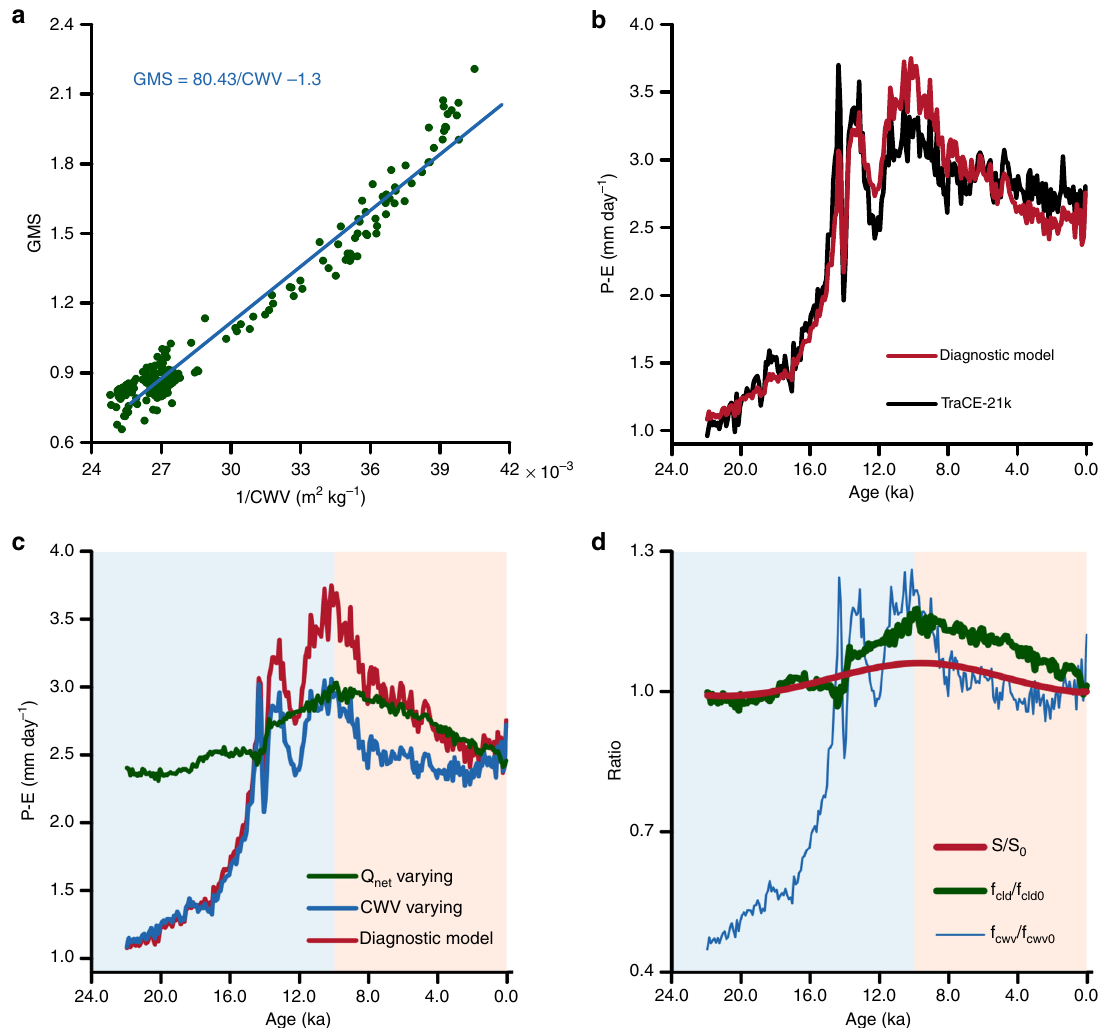
Fig. 2 The Indian summer monsoon as a function of net energy and water vapor. a The scatter between gross moist stability (GMS) and total column water vapor (CWV) over India. b The time series of moisture convergence ( P (cid:3) E ) over India from the TraCE-21k (black) and the diagnostic model (red). c The time series of P (cid:3) E from the diagnostic model over India under three conditions, namely, only net downward radiative fl ux at the top of the atmosphere ( Q ) varies, and CWV is held constant at its preindustrial value (in green), only CWV varies, whereas Q net blue), and, fi nally both CWV and Q vary (in red). d The time series of solar insolation ( S ) in red, cloud radiative feedbacks ( f cld ) in blue, and the effect of net water vapor ( f ) in green, normalized with respect to their preindustrial values. The preindustrial climate is obtained by taking the average over the period cwv 1750 – 1850 AD. The background colors indicate the two periods classi fi ed based on the dominance of water vapor (shown in blue) or Q